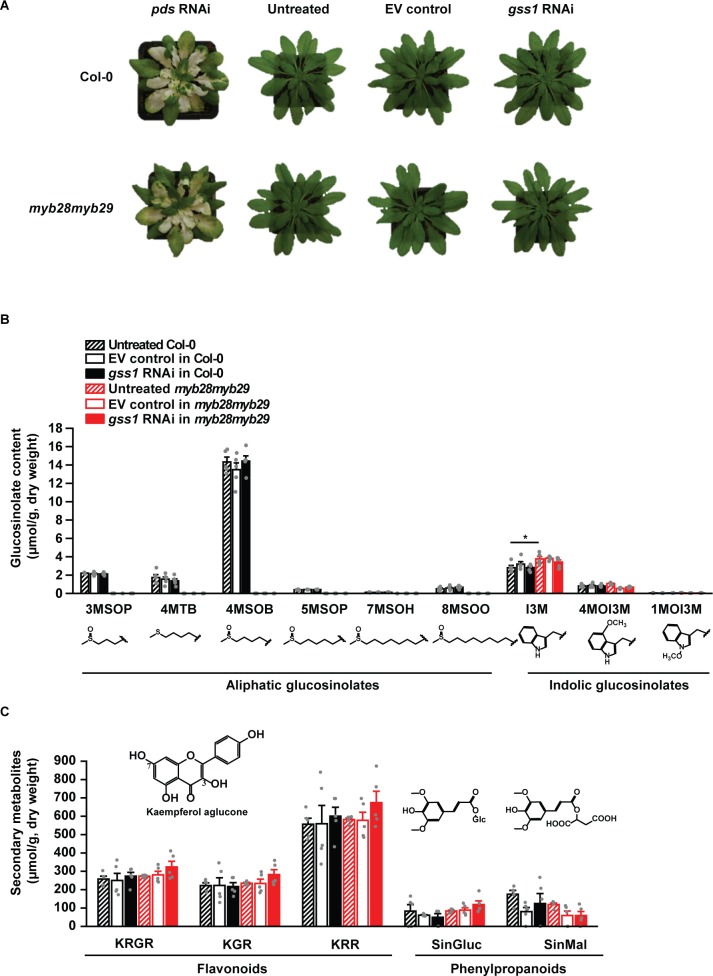
Infiltration of A.thaliana Col-0 and myb28myb29 lines with gss1 RNAi and empty vector (EV) control constructs does not alter their morphology and chemical phenotypes.(A) Morphology of untreated, EV control and gss1 RNAi plants in Col-0 and myb28myb29 backgrounds. Phytoene desaturase (pds) RNAi constructs were used as a positive control of virus induced gene silencing. Photographs were taken 4 weeks after infiltration. (B) Glucosinolate profiles of untreated, EV control, and gss1 RNAi plants in Col-0 and myb28myb29 backgrounds (I3M, F5,24 = 4.031, p≤0.01, n = 5 in all bars). 3MSOP: 3-methylsulfinylpropyl; 4MSOB: 4-methylsulfinylbutyl; 5MSOP: 5-methylsulfinylpentyl; 7MSOH: 7-methylsulfinylheptyl; 4MTB: 4-methylthiobutyl; 8MSOO: 8-methylsulfinyloctyl; I3M: Indol-3-ylmethyl; 4MOI3M: 4-methoxyindol-3-ylmethyl; 1MOI3M: 1-methoxyindol-3-ylmethyl glucosinolate. (C) Concentrations of selected secondary metabolites (flavonoids and phenylpropanoids) in untreated, EV control, and gss1 RNAi plants in Col-0 and myb28myb29 backgrounds. KRGR, kaempferol 3-O-glucoside-2’’-rhamnoside-7-O-rhamnoside; KGR, kaempferol 3-O-glucoside-7-O-rhamnoside; KRR, kaempferol 3-O-rhamnoside-7-O-rhamnoside; SinGluc, 1-O-sinapoyl-β-D-glucose; SinMal, sinapoyl malate. Significant differences (p≤0.05) between means (±s.e.) were determined by Tukey HSD tests in conjunction with one-way ANOVA in B and C.Figure 1—figure supplement 3—source data 1.Glucosinolate, flavonoid, and phenylpropanoid profiles in A. thaliana plants.